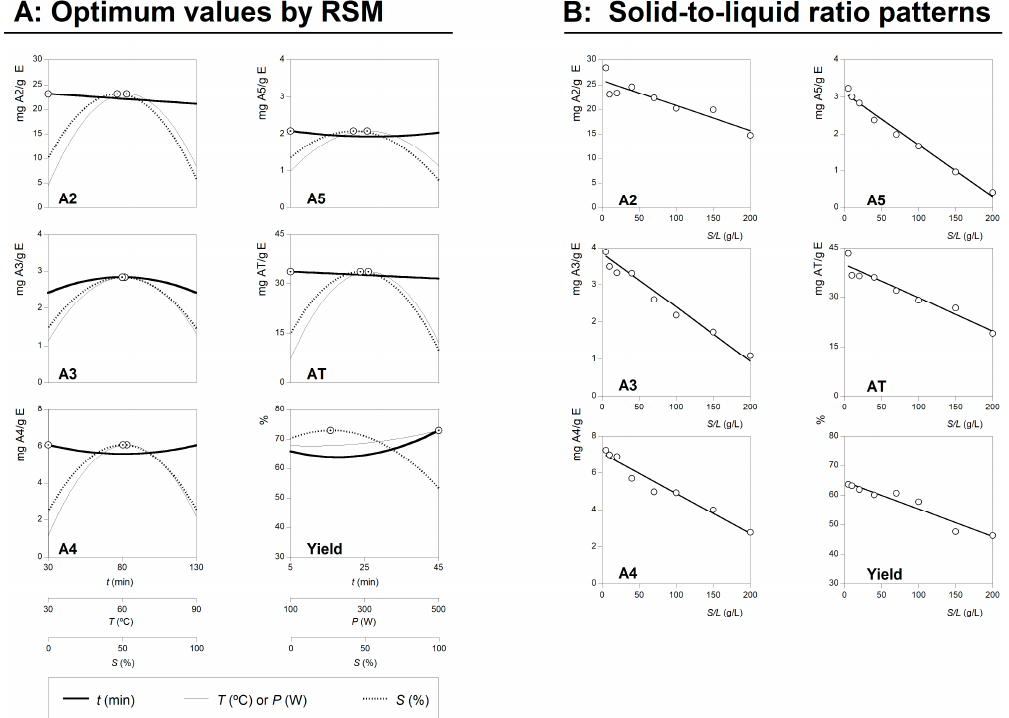
Figure 2. Final summary of the HAE e ff ects of all variables assessed. Part A: Shows the individual 2D responses of all studied responses as a function of all the variables assessed. The variables in each of the 2D graphs were positioned at the individual optimal values of the others (Table 1B2). The dots ( (cid:12) ) presented alongside each line highlight the location of the optimum value. Lines and dots are generated by the respective theoretical second order polynomial derived from Equation (1). Part B: Shows the dose response of S / L at the global optimal values of the other three variables (Table 1B2). Experimental results are the dots ( ), meanwhile the lines are the predicted pattern created by a linear equation with an intercept. The limit value (~200 g/L) shows the maximum achievable experimental concentration until the sample cannot be physically stirred at laboratory scale.